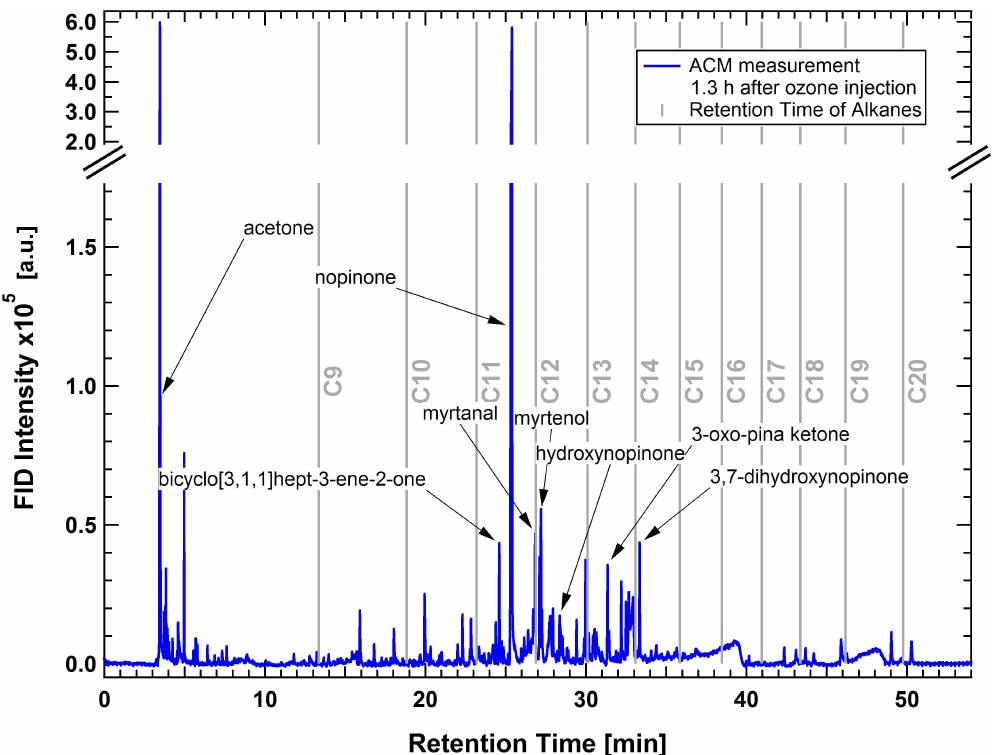
Fig. 5. ACM GC-FID chromatograms measured at the beginning of the experiment. The grey vertical bars indicate the retention times of the homologous series of alkanes from the GC/MS-FID calibration which were used to calculate linear retention indices